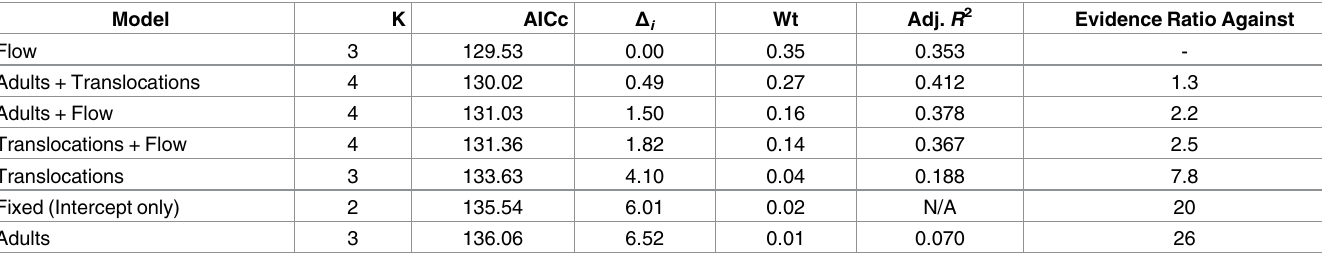
Table 5. Models for YOY Length in October, ranked by AICc.